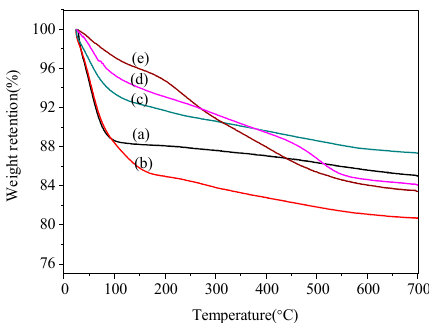
Figure 4. Thermogravimetric curves of SiO 2 -H ( a ), SiO 2 -C ( b ), Si-P 8 TFSI/SiO 2 -H(I) ( c ), Si-P 8 TFSI/SiO 2 - / SiO H(II) ( d ), and Si-P 8 TFSI/SiO 2 -C ( e ). SiO 2 -H(II) ( d ), and Si-P 8 TFSI 2 -C ( e